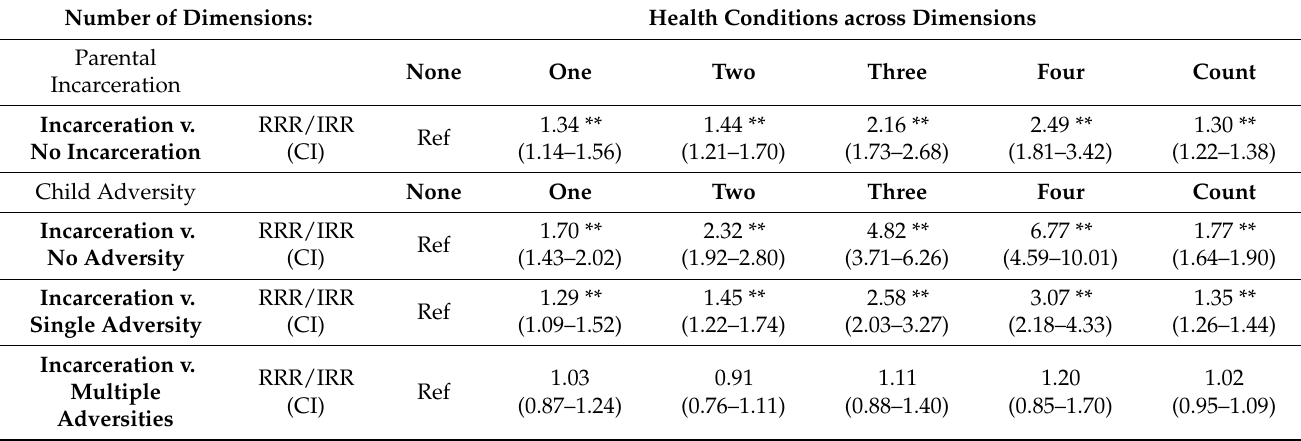
Table 3. Parental Incarceration and Child Health across Dimensions: A Strategic Comparison Approach. Health Conditions across